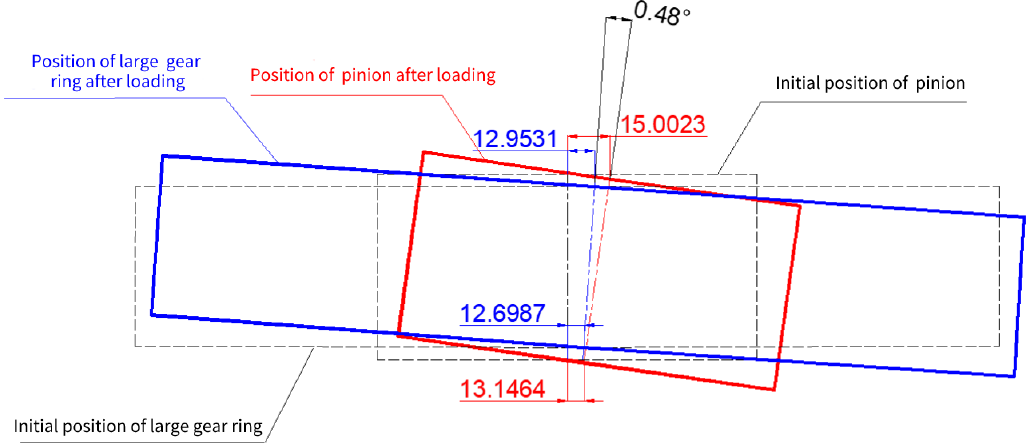
Figure 16. Diagram of gear axis angle after being loaded.